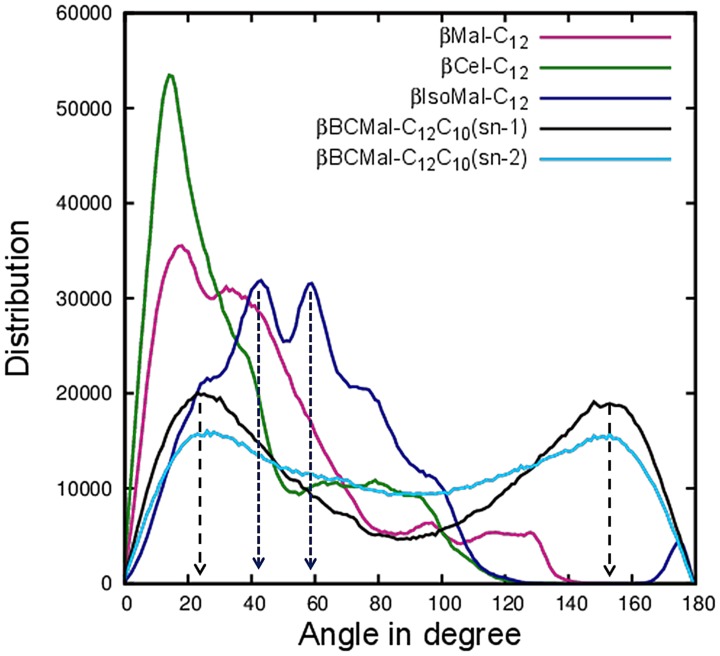
Distributions of alkyl chain tilt angle θ of various glycolipids for one layer.Shows the current results for 160βMal-C12, black for βBCMal-C12C10 (sn-1), deep sky blue for βBCMal-C12C10(sn-2), green for βCel-C12 and dark blue for βIsoMal-C12.